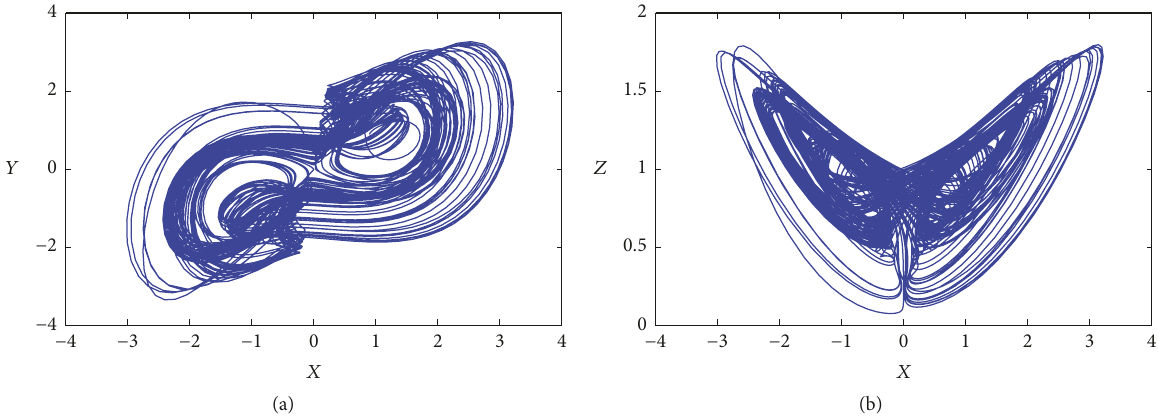
Figure 3: The solution on a phase diagram for 𝛼 = 5 , 𝑅 = 25 , 𝜎 1 = 4.5 , and 𝜂 = 0 . 𝑌 versus 𝑋 (a) and 𝑍 versus 𝑋 (b).